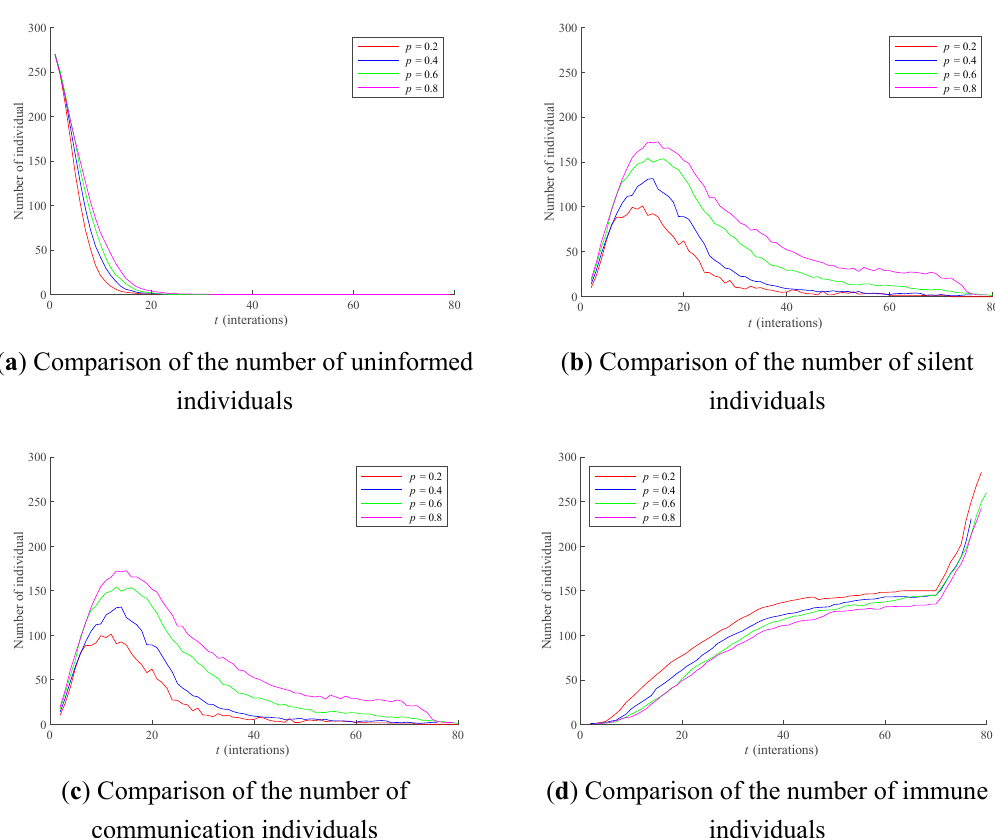
Figure 9. The influence of different p on thedissemination process of public opinion. Note: ( a ) Comparison of the number of uninformed individuals, ( b ) Comparison of the number of silent individuals, ( c ) Comparison of the number of communication individuals, ( d ) Comparison of the number of immune individuals.